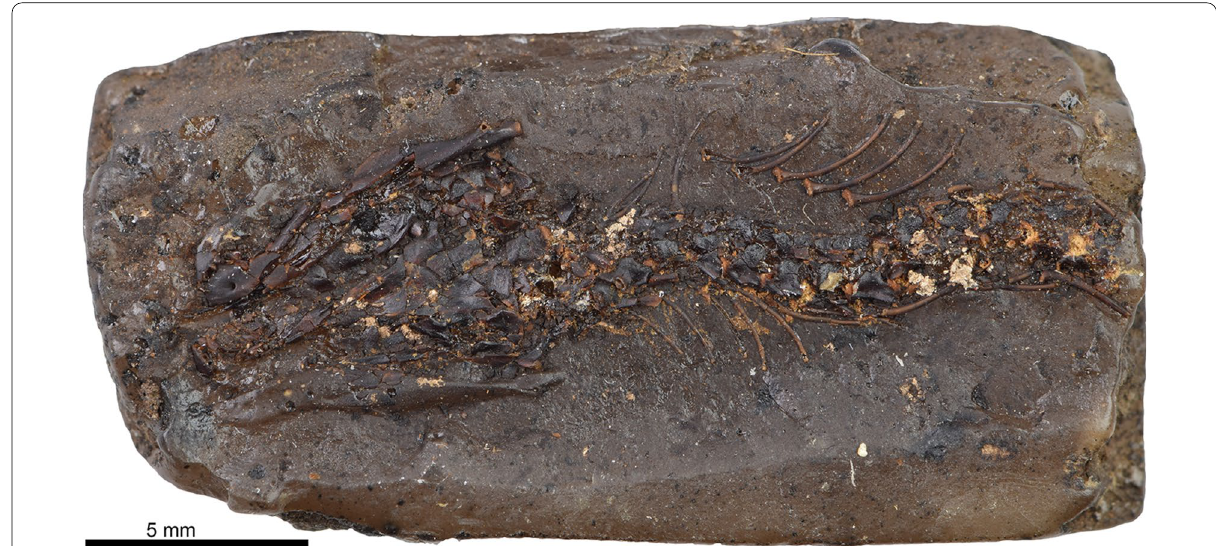
Fig. 108 Constrictores indet. from quarry Cecilie III, Geiseltal: anterior skeleton of a young individual (“baby”), including crushed skull and several anterior trunk vertebrae and remains of ribs (GMH Ce III-2928-1932) from quarry Cecilie III. Specimen originally figured by Kuhn (1939a:pl. I.1)